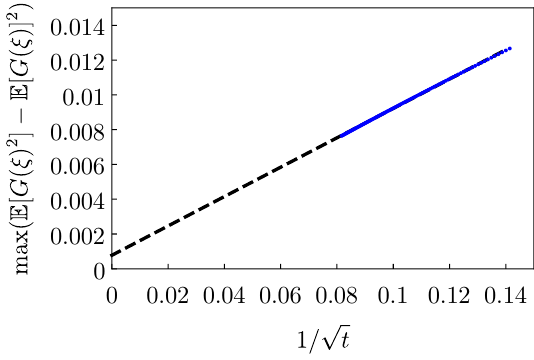
Figure 10: In this plot we show the scaling of the maximal difference, with respect to the coordinate ξ , between the average of square of (cid:69) [ G ( ξ ) 2 ] for times between 50 and 150 and the square of expression (173) (blue dots). We can see that the difference decays as 1 (cid:112) . Indeed, the linear extrapolation (black line) yields the value t at the origin 8 × 10 − 4